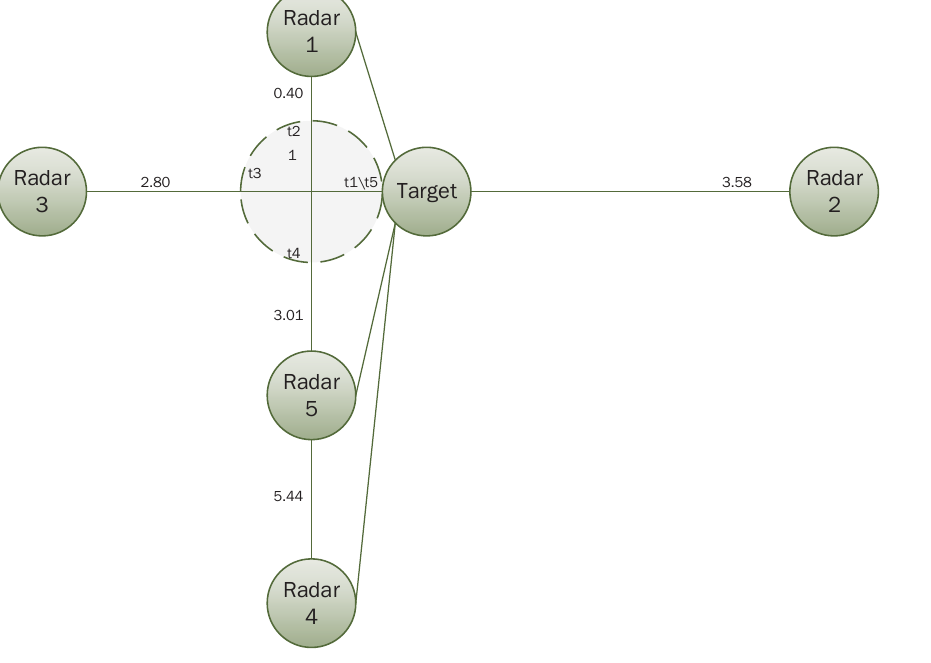
Figure 10. Relative position of five radars with the target when the target moves along curves.